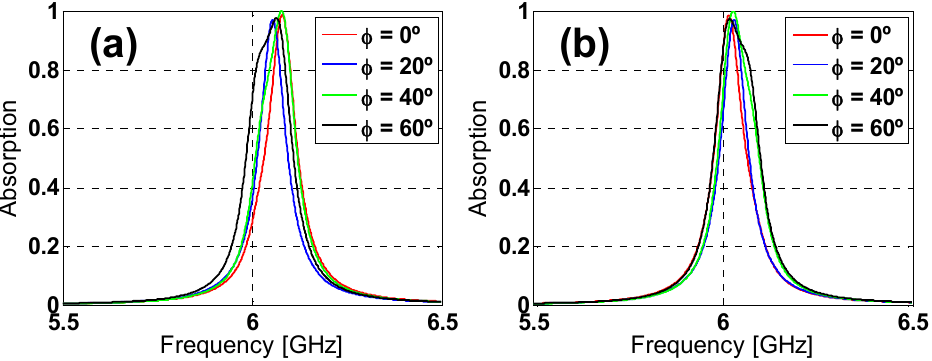
Figure 10. Star design absorption in simulation with Arlon25N and different polarization angles ( ϕ ) of the incident field for both ( a ) TE and ( b ) TM polarizations.